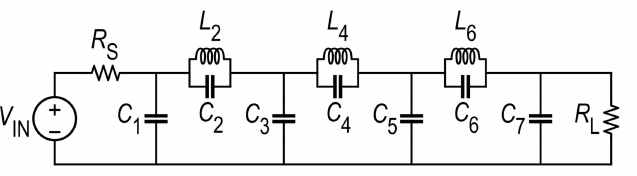
Figure 3. Ladder prototype of the SC LPF. Reproduced from [25]. Copyright 2021,